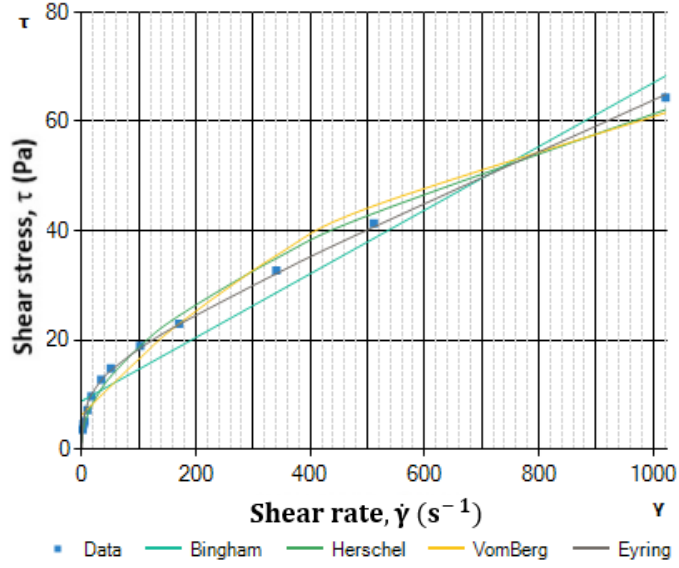
Figure 3. Comparison of the selected rheological models, cement w/c 0.44.